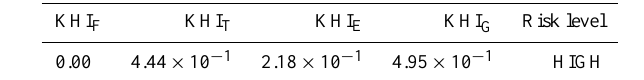
Table 8. Risk indexes obtained from the presented methodology (KHIs) for case study